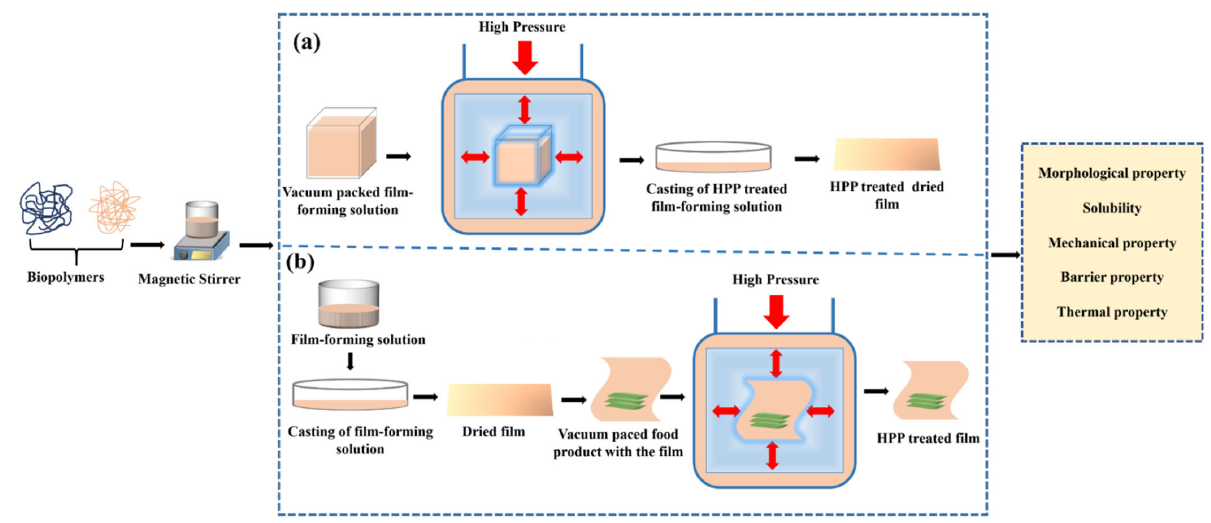
Figure 2. A graphical representation of the application of HPP on the films: ( a ) HPP applied to film‐forming solution; ( b ) HPP applied on the dried film.